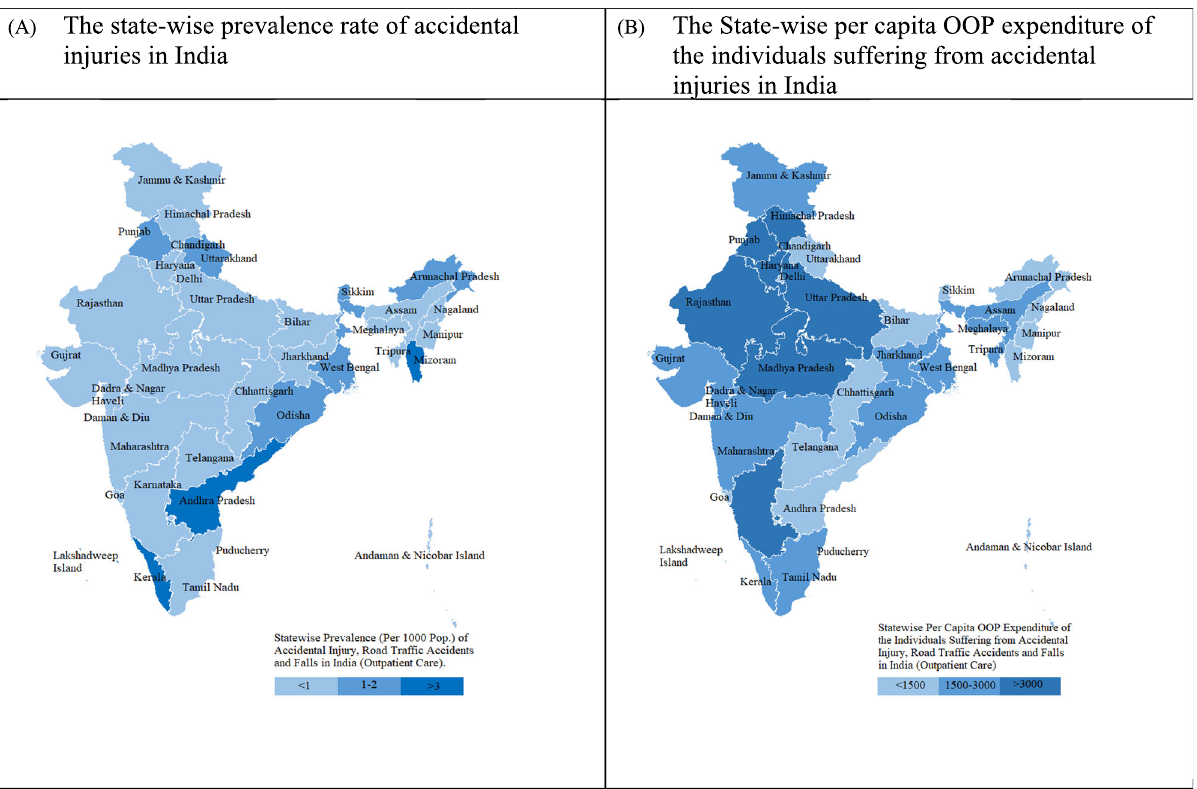
Fig. 2 Graphical illustration of state-wise prevalence rate of accidental injuries and per capita OOP expenditure of the individuals suffering from accidental injuries in India 2017 – 18 (Outpatient care). A The state-wise prevalence rate of accidental injuries in India. B The State-wise per capita OOP expenditure of the individuals suffering from accidental injuries in India. Figures are based on the author ’ s calculations from NSSO 75th